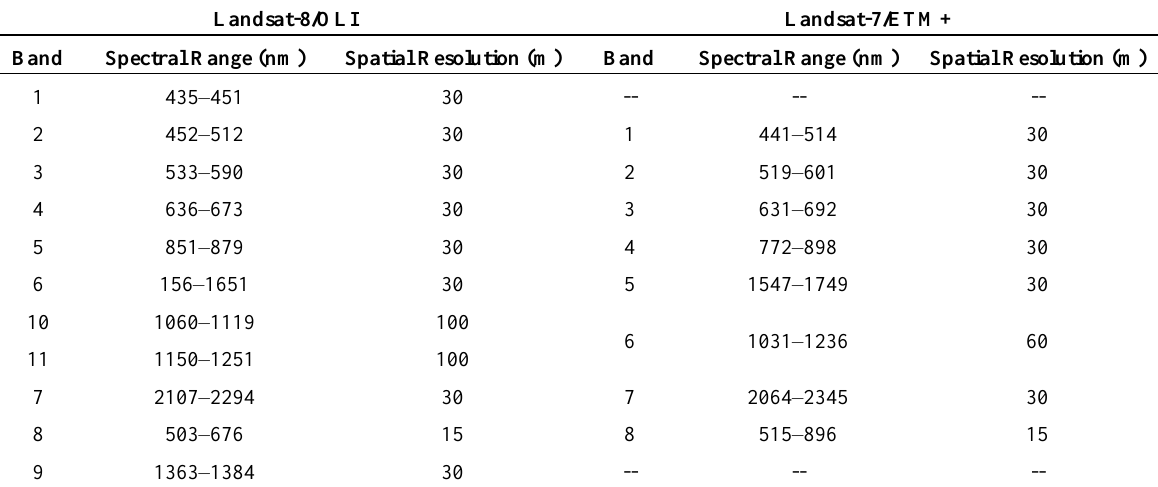
Table 2. Comparison between Landsat-8/OLI and Landsat-7/ETM+